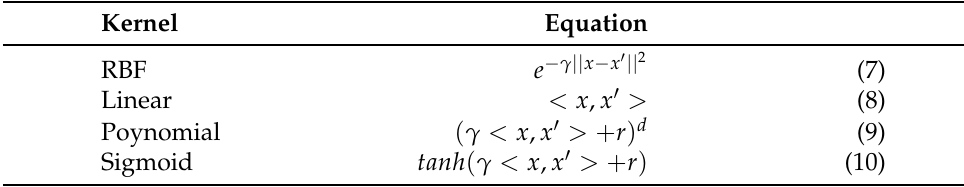
Table 2. Four Common kernel functions used for